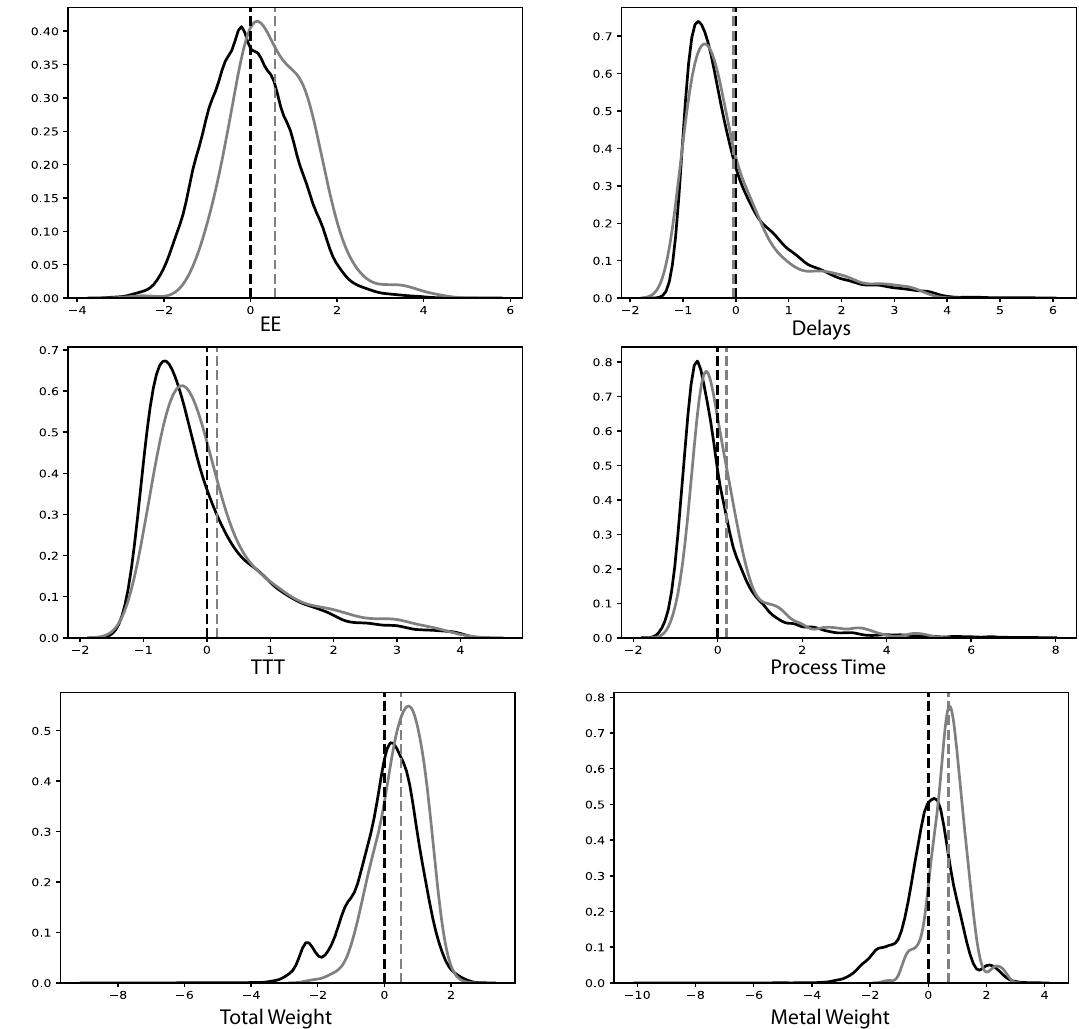
Figure 8. Distributions for the training data (black) and test data (gray) for EE and the 5 of the variables with higher FI for the 6 selected models. The vertical dashed lines show the mean of each distribution. Both the training and test data are normalized with the mean error and standard deviation of error of the training